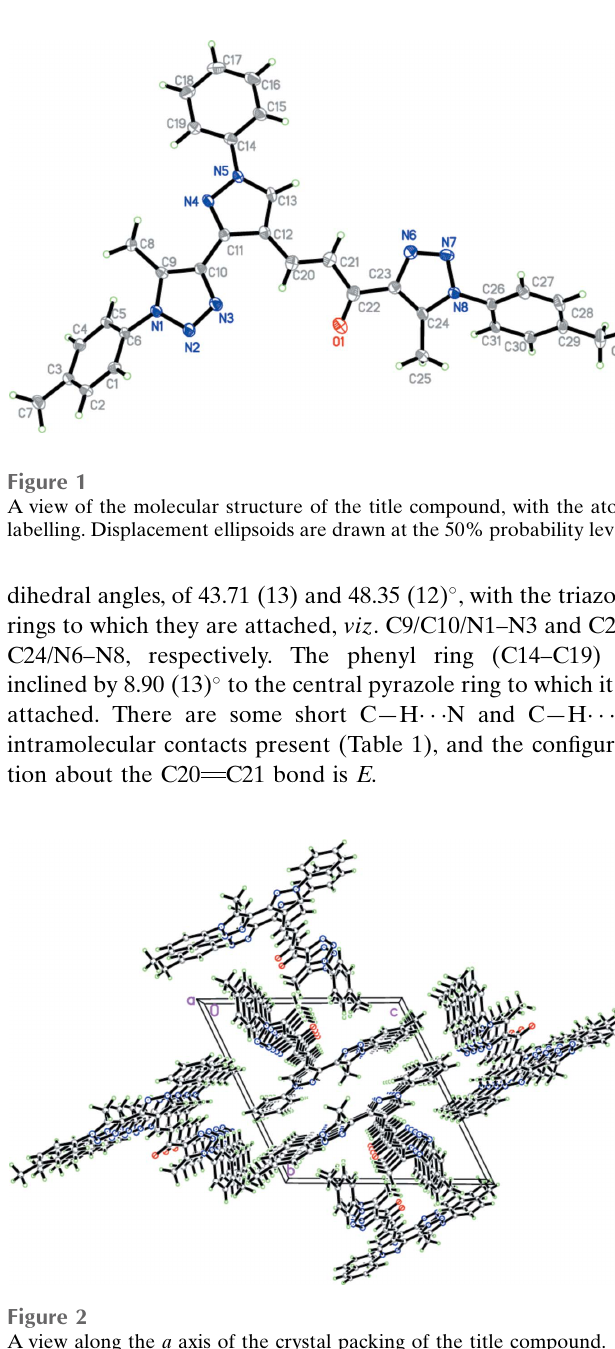
Figure 2 A view along the a axis of the crystal packing of the title compound.